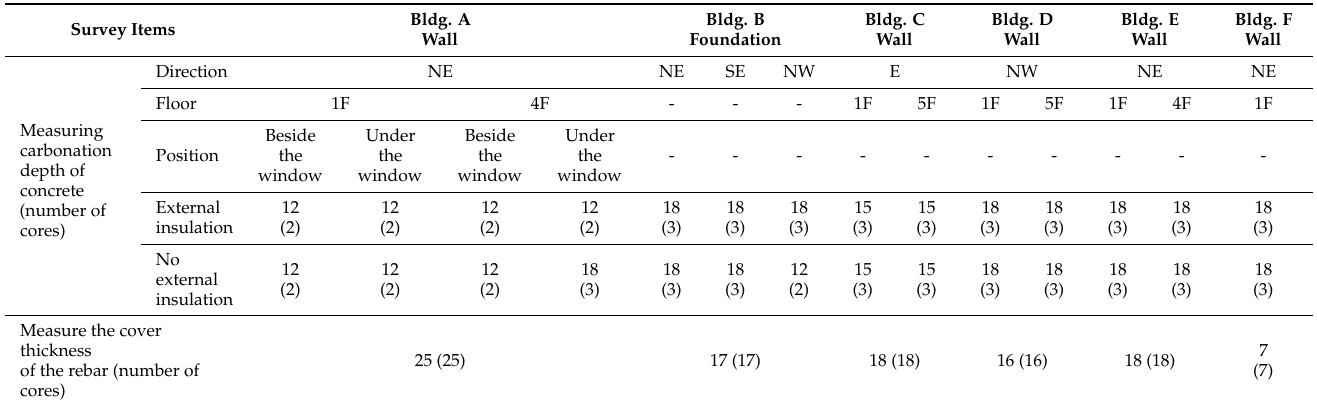
Table 2. Survey items, sampling positions, and the number of